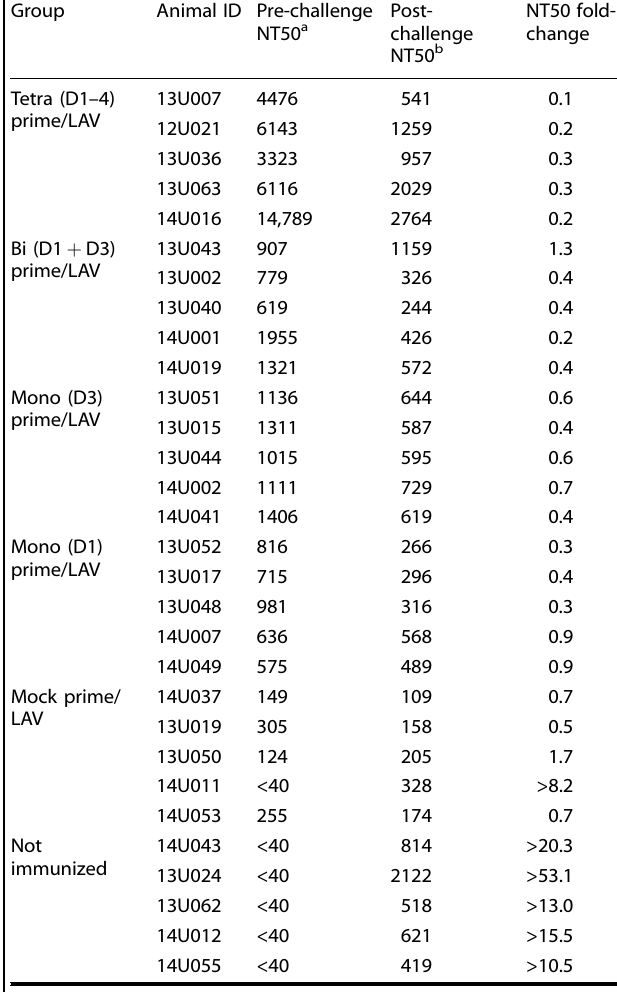
Table 4. Neutralizing antibody titers pre- and post-challenge with wild-type